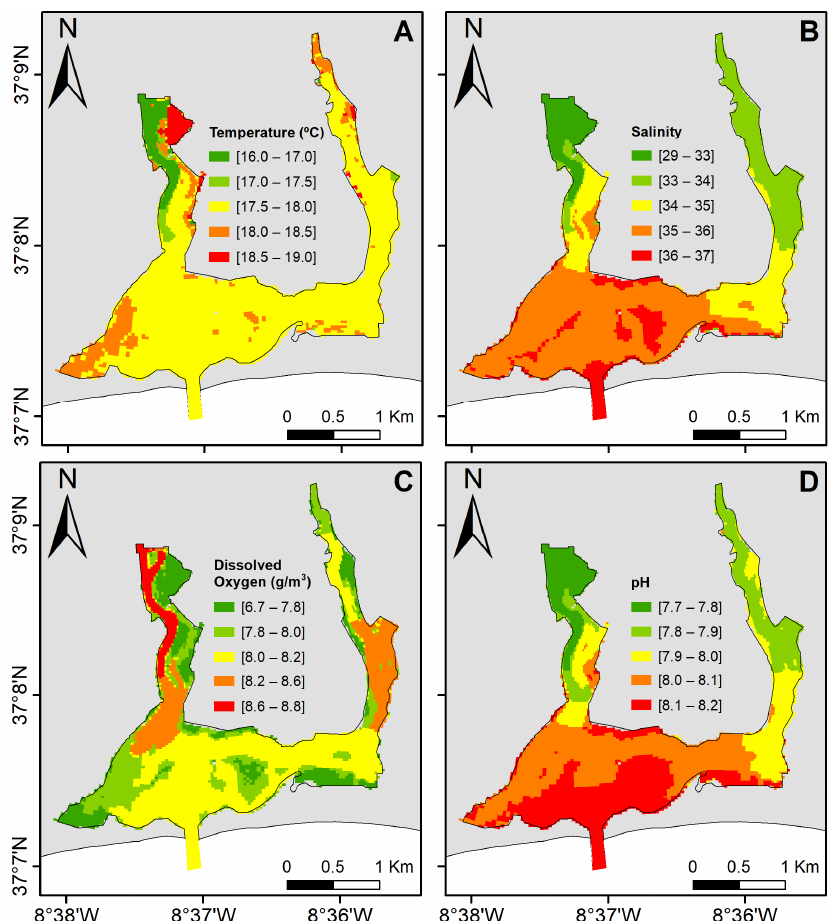
Figure 10. Annual mean water temperature (°C) ( A ), salinity ( B ), DO (g/m3) ( C ), and pH ( D ) for Ria de Alvor.